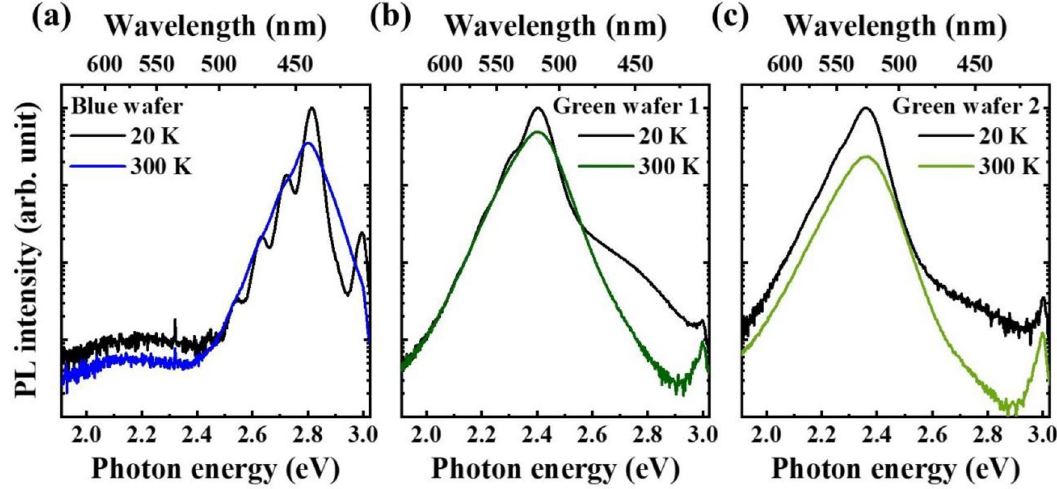
Figure 1. PL spectra taken at 20 K and 300 K for ( a ) blue LED wafer, ( b ) green LED wafer 1, and ( c ) green LED wafer